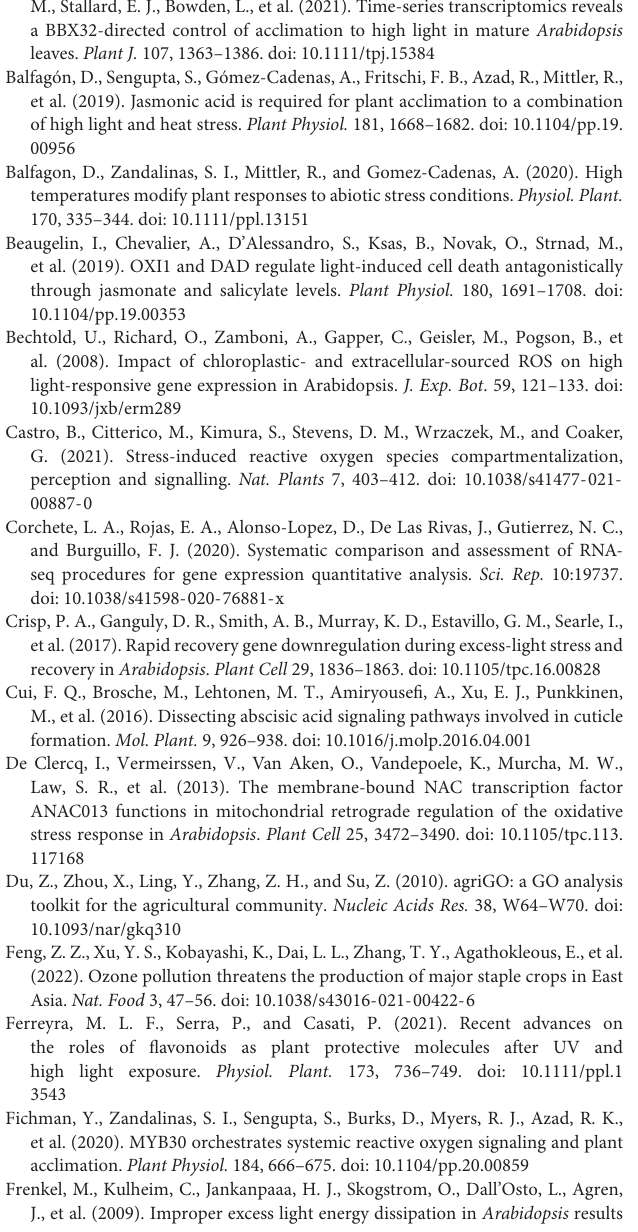
Supplementary Table 1 | Primers used in this study.